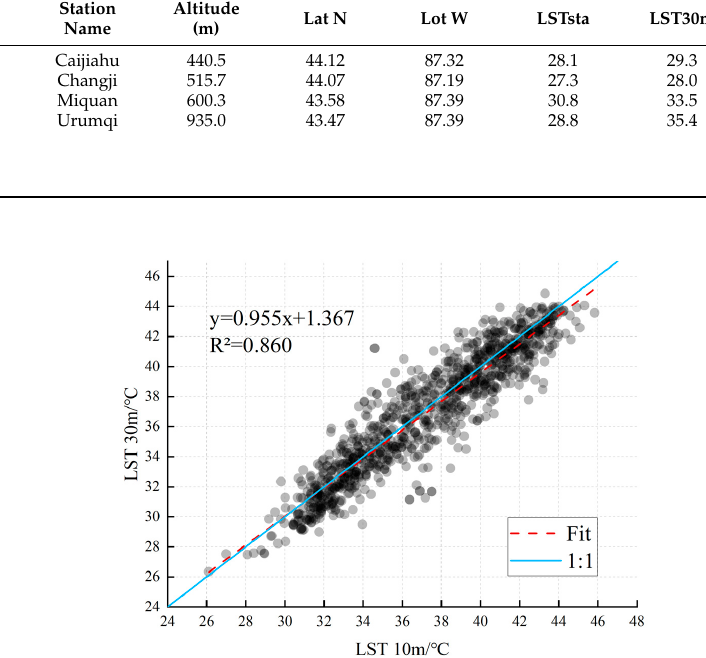
Figure 5. Local 3D architectural map of the study area: ( a ) is LST30m; ( b ) is LST10m. 3.1.2. LST10m Spatial Distribution Characteristics This paper used the mean-standard deviation method to classify the downscaled LST classes (Figure 6). It can be seen from the figure that ELT and LT are primarily distributed in the cultivated land in the north of the study area and MT is distributed mainly in the urban built-up area, while HT and EHT are primarily distributed in the unutilized land in the south of the study area. The study area has a high percentage of HT overall, fol- lowed by MT and LT. Among them, HT has the highest proportion of LST in Urumqi City; LT has the highest ratio of LST in Changji City; and MT has the highest LST in Wujiaqu City. This is due to the high level of urbanization in Urumqi City and a certain range of bare land, resulting in a relatively high LST, while Changji City occupies a large area of cultivated land, so the LST is relatively low; Wujiaqu City has no large-scale cultivated land, and the urbanization level is low, so the LST is at the middle level. This means that after neglecting the peripheral landscape (unused land such as desert) of the oasis in the arid zone, the town expansion still causes UHI and is more destructive to the cold and wet climate of the oasis. In addition, from the local map of the city in the study area and com- bined with the surface parameter information of S2 (Figure 3), it can be seen that the re- sults of LST downscaling inherit the high-resolution urban profile information of S2 bet- ter.